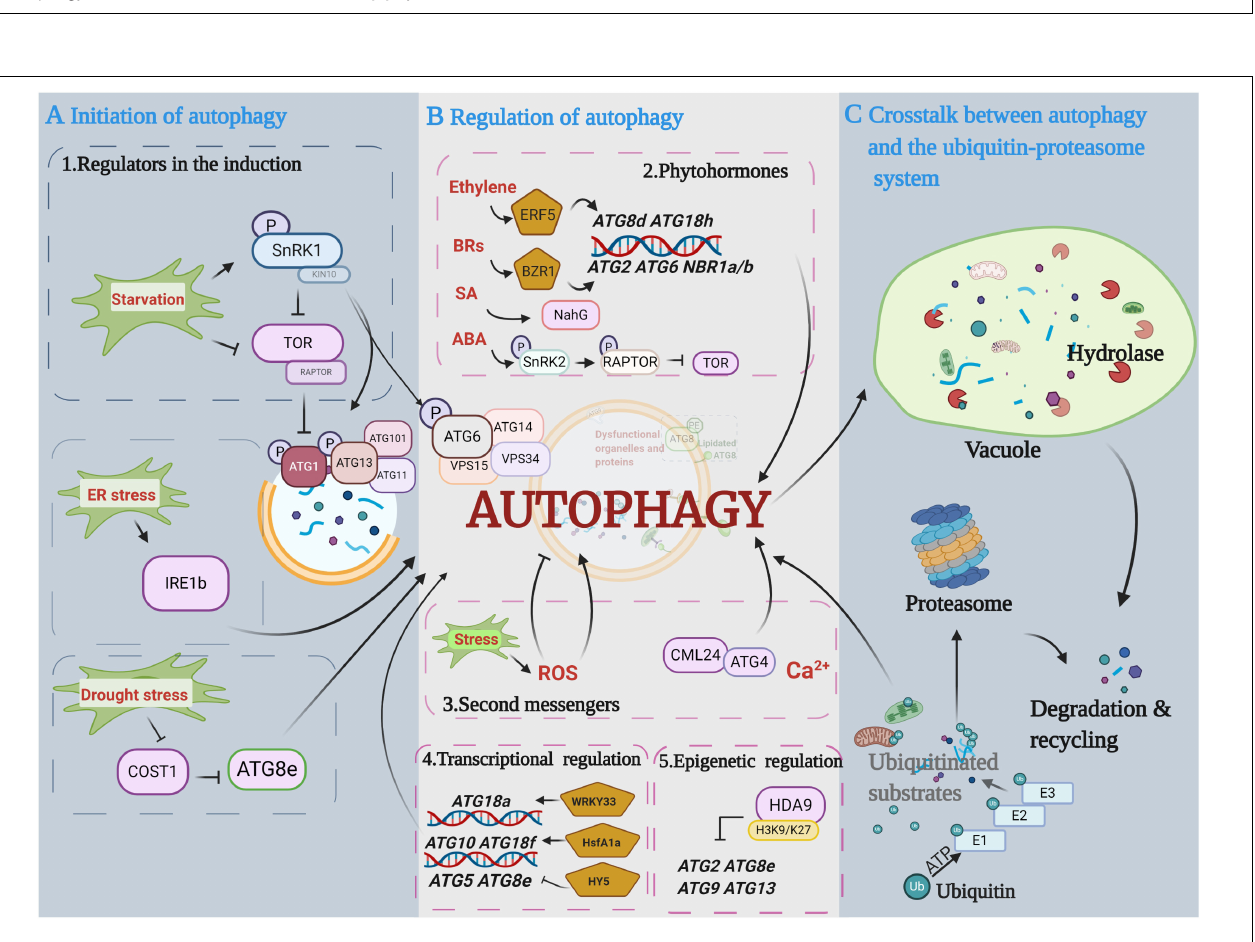
FIGURE 2 | Diagram depicting the main proposed events in the autophagy pathway. (A) Initiation of autophagy. Autophagy is initiated by protein kinases and developmental and environmental signals. Autophagy induction and nucleation involve the autophagy-related gene 1 (ATG1) complex that is negatively controlled by target of rapamycin (TOR) kinase and activated by sucrose nonfermenting-1-related protein kinase 1 (SnRK1) kinase. (B) Regulation of autophagy in autophagosome expansion and maturation. Multiple regulatory mechanisms are involved in autophagy processes, including phytohormones, secondary messengers, and transcriptional and epigenetic regulators. (C) Crosstalk between autophagy and the ubiquitin-proteasome pathway (UPS). Ubiquitinated substrates are precisely identified and degraded by the UPS and autophagy pathways, respectively. This figure was created by BioRender (https://biorender.com/).